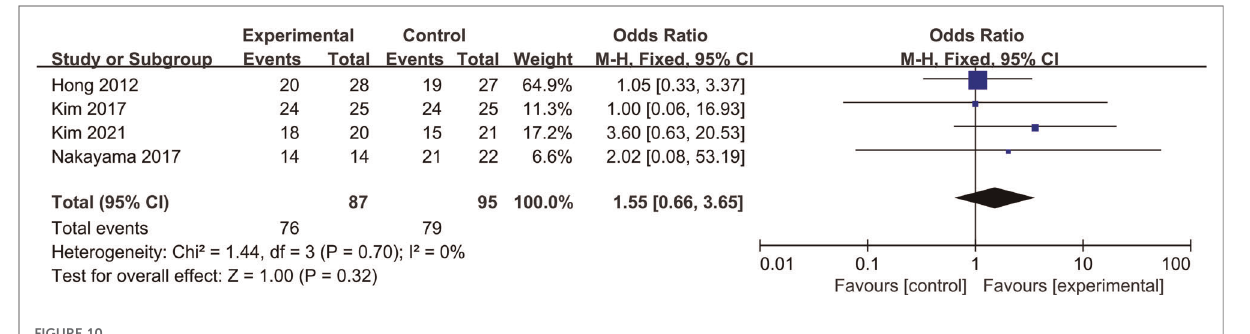
FIGURE 10 Forest pot for synovial